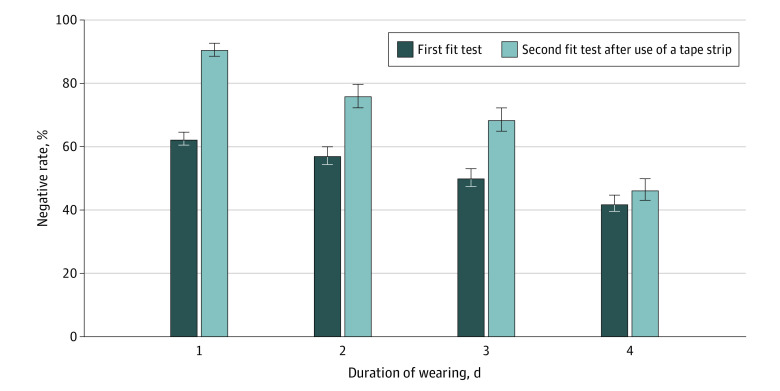
Rate of Negative Results in the First and Second Fit TestsError bars indicate 95% CI.